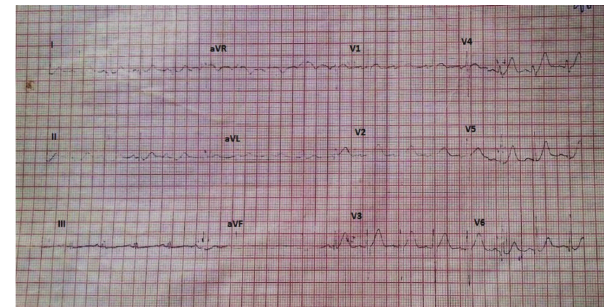
Figure 1: Baseline electrocardiogram.